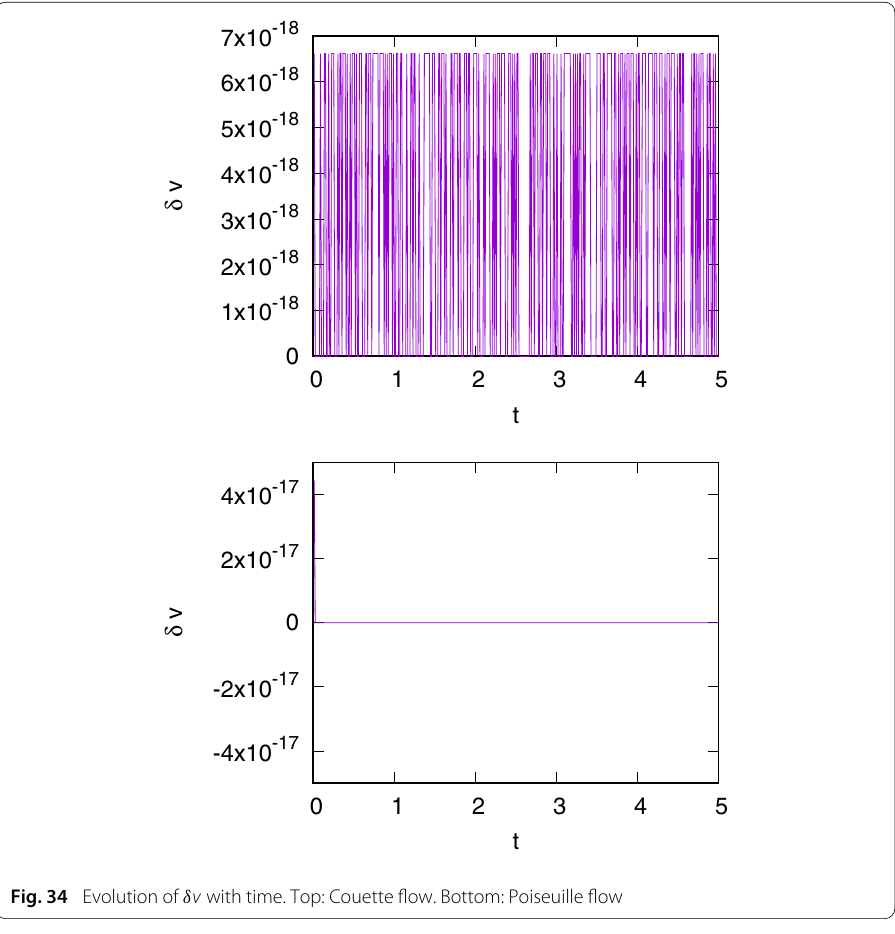
Fig. 34 Evolution of δ v with time. Top: Couette flow. Bottom: Poiseuille flow